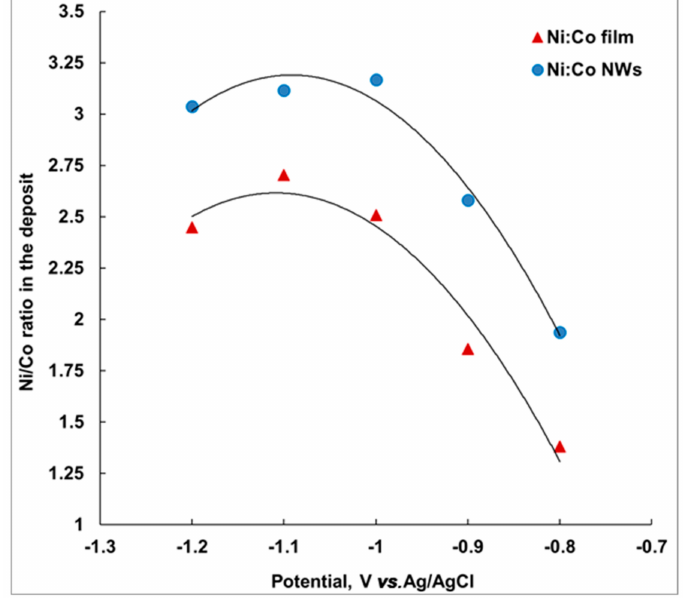
Figure 9. Potential dependence of the Ni / Co ratio in the deposit for film and nanowires at di ff erent potentials (the solid lines indicate the polynomial trend and are shown only to visually guide the variation of the Ni / Co ratio with the applied